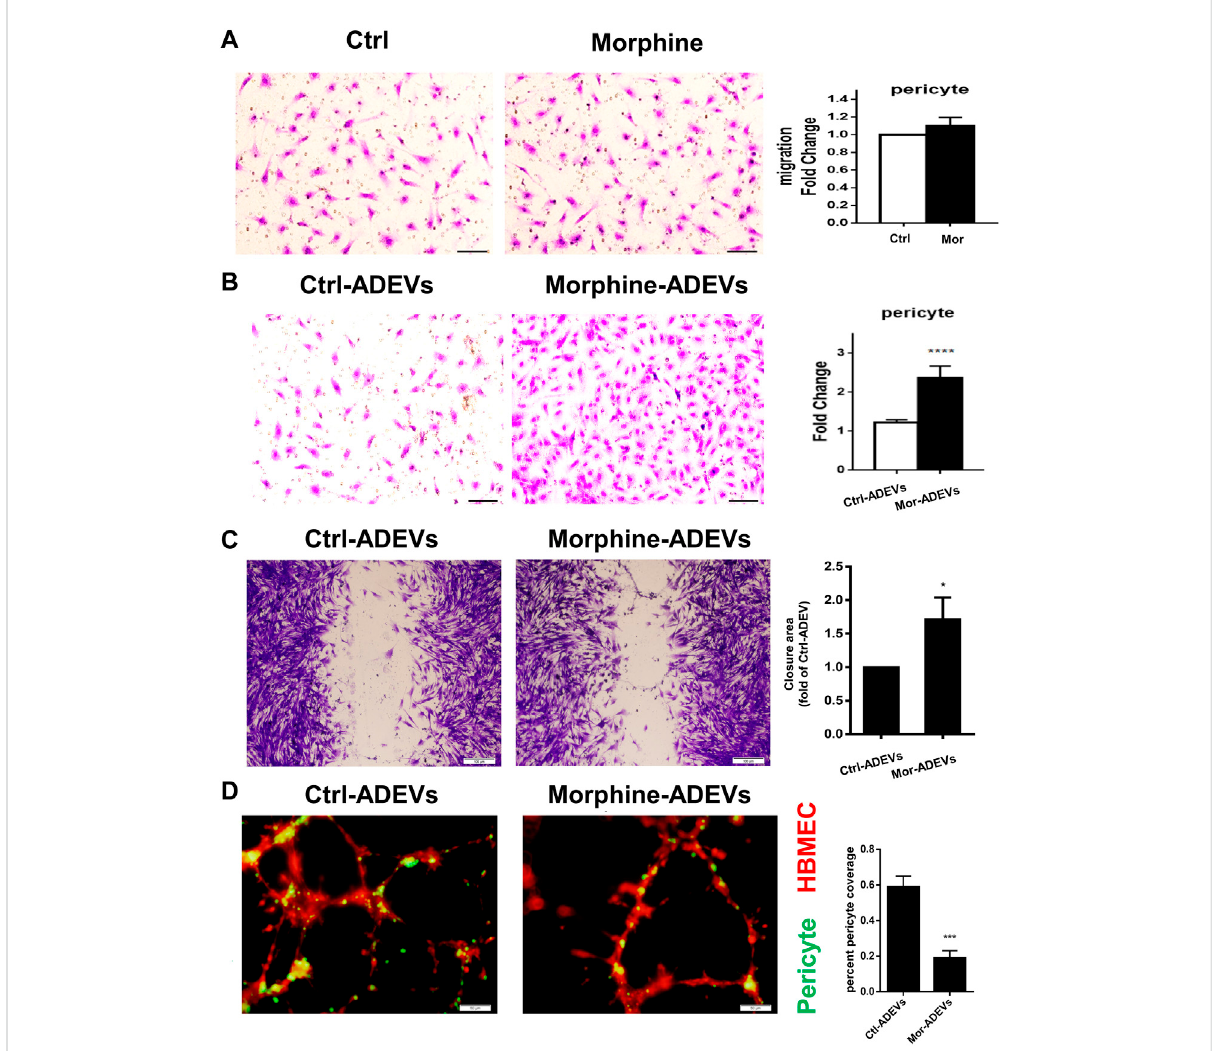
FIGURE 2 Morphine-ADEVs induce pericyte migration and loss in vitro . (A) The migration of pericytes that responded to morphine was measured by transwellmigrationassay.Migratedpericyteswerestainedwithcrystalviolet.Scalebar=20 µm.Quanti fi cationofmigratedpericytesisshownonthe right. N = 9 (B) The migration of pericytes responded to morphine-ADEVs was measured by transwell migration assay. Migrated pericytes were stained with crystal violet. Scale bar = 20 µm. Quanti fi cation of migrated pericytes is shown on the right. N = 9 (C) Migration of pericyte respondedtomorphine-ADEVswasmeasuredbythescratchassay.Therepresentativeimagesofpericytestainedbycrystalvioletandthenanalyzed by ImageJ software. Scale bars, 100 μ m. N = 9 (D) Loss of pericyte was measured in the 3D pericyte (green)-endothelia (Red) coculture model. The coverage of pericytes was analyzed by ImageJ. Scale bars, 50 μ m. N = 9 All data are presented as mean ± SD of 3 individual experiments, * p